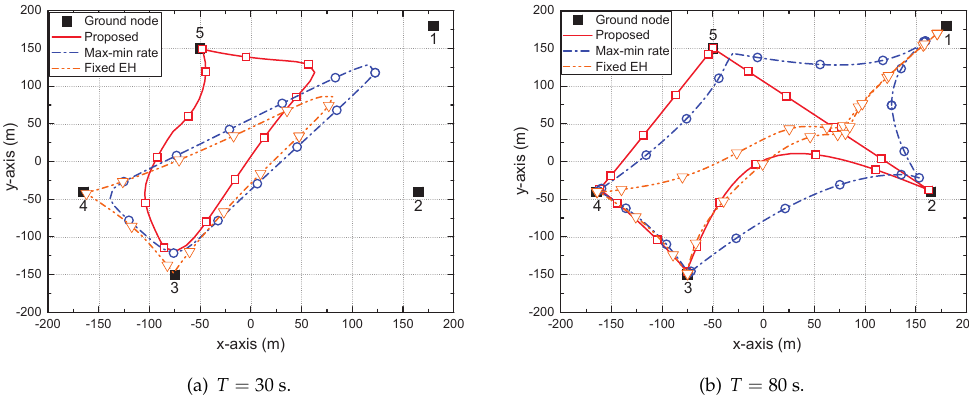
Figure 3. Trajectory of the UAV for different values of T . Upload modified figure files as R22 and R33 in Fig2